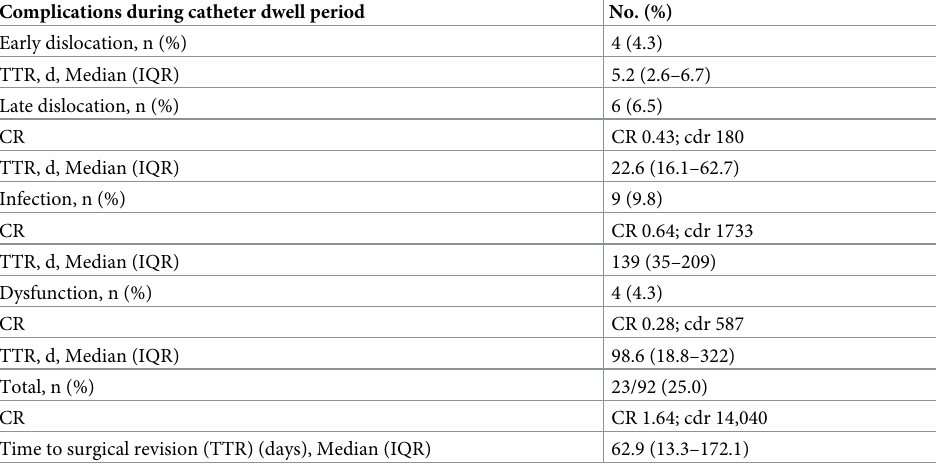
Table 3. Complications during catheter dwell period.